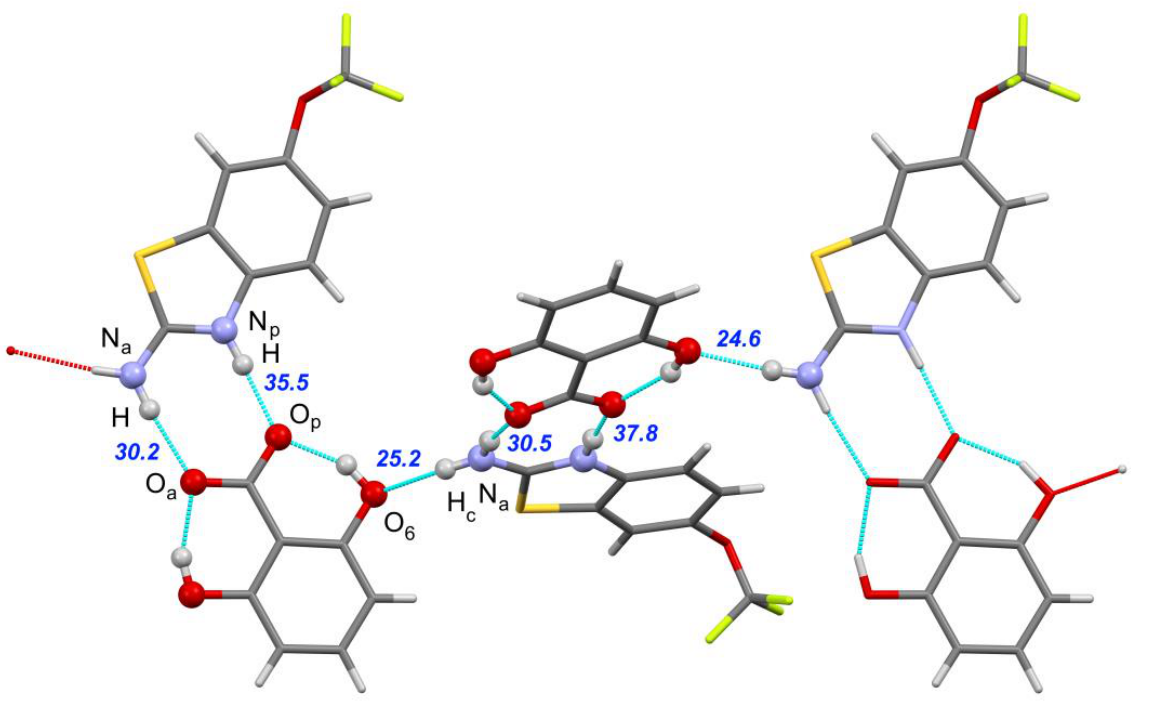
Figure 1. The H-bonded chain in crystalline [RLZ+2,6DHBA] (1:1). The asymmetric unit contains two inequivalent RLZ+2,6DHBA heterodimers. H-bonds are shown as dotted lines. Numbers indicate the enthalpies of intermolecular H-bonds estimated using Equation (1) at the PBE-D3 level. H c denotes the H atom of the amino group of the RLZ molecule in the cis -position with respect to the S atom (Scheme 1).